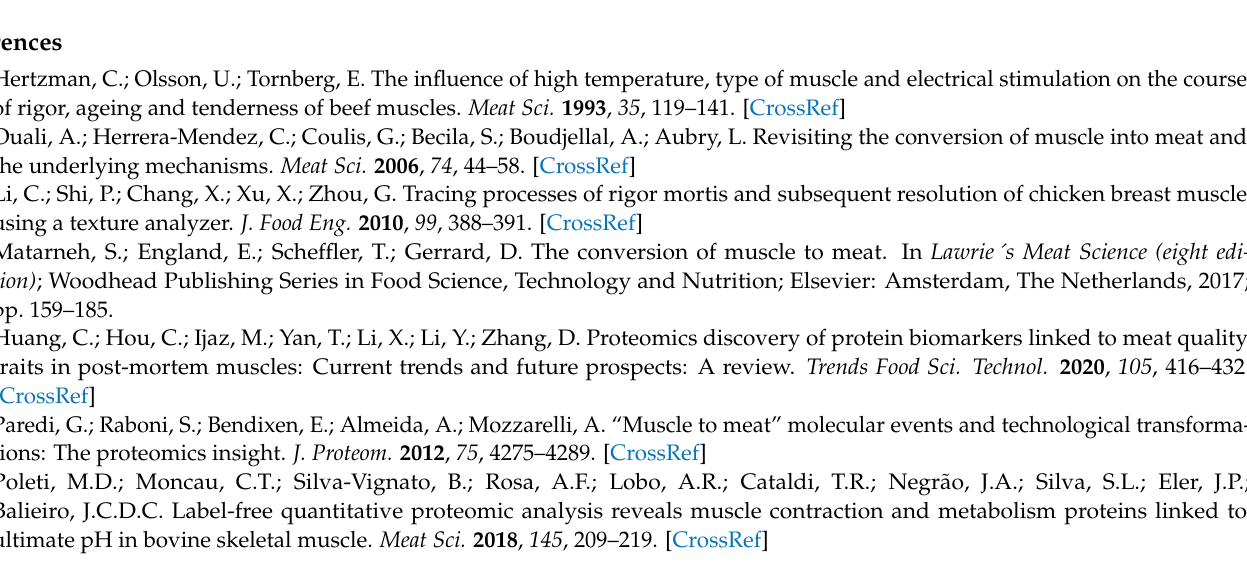
Table S5: KEGG pathway analyses of the differentially expressed proteins between 6 h and 0 h PM; Table S6: KEGG pathway analyses of the differentially expressed proteins between 24 h and 6 h